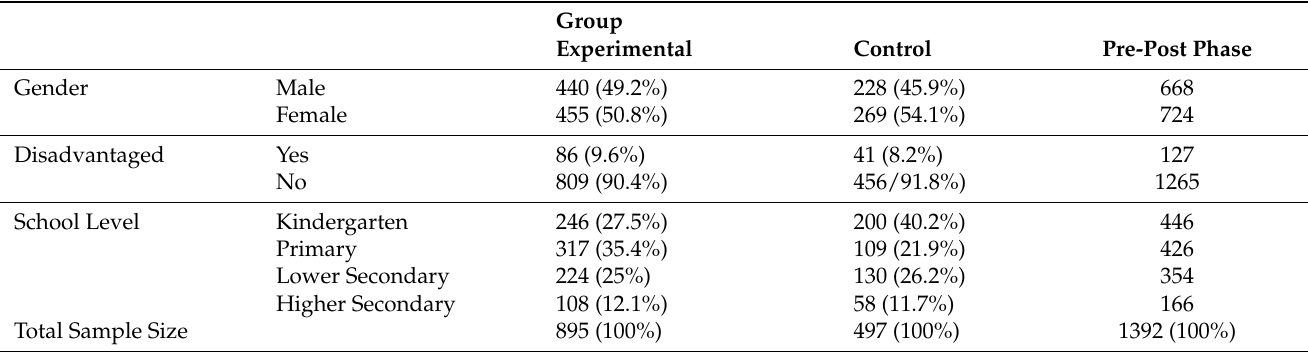
Table 1. Sample of students by gender, status, and school level.